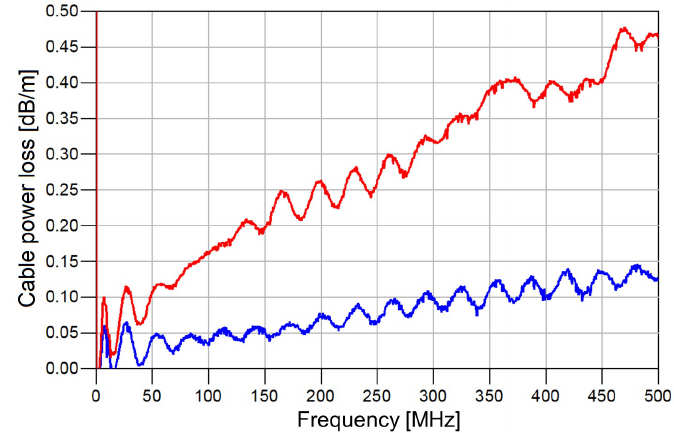
Figure 4. Losses of coaxial cables per unit length in the case of standard coaxial cable (red) and high-quality coaxial cable produced by Fujikura company